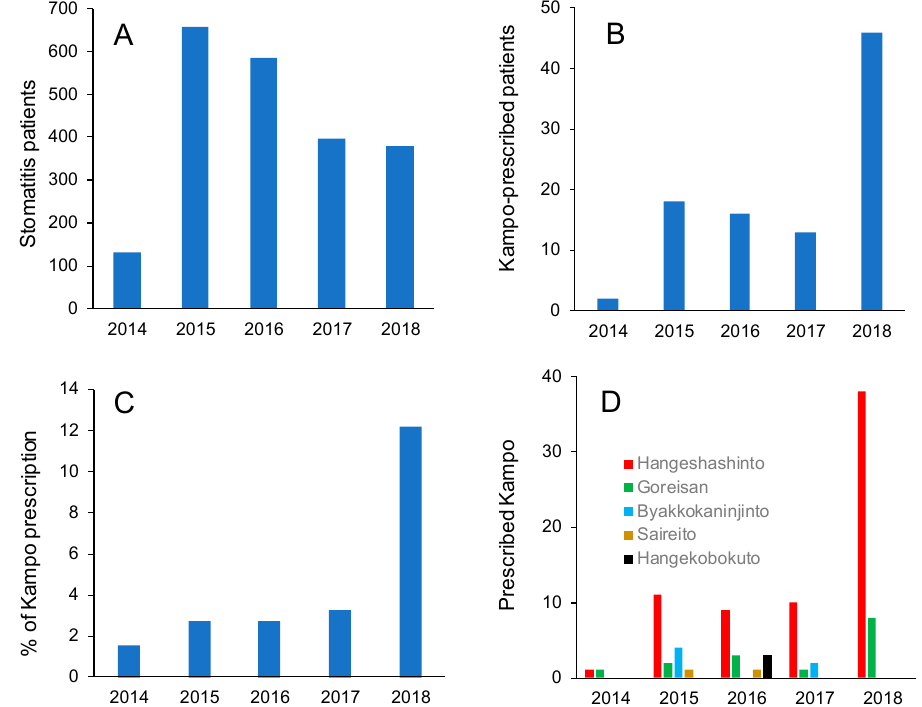
Figure 1. Changes in number of stomatitis patients ( A ), number of Kampo-prescribed stomatitis patients ( B ), percent of Kampo prescription ( C ) and number of prescribed Kampo medicines ( D ) during 2014 to 2018 (Data from hospital of Nihon University School of Dentistry).